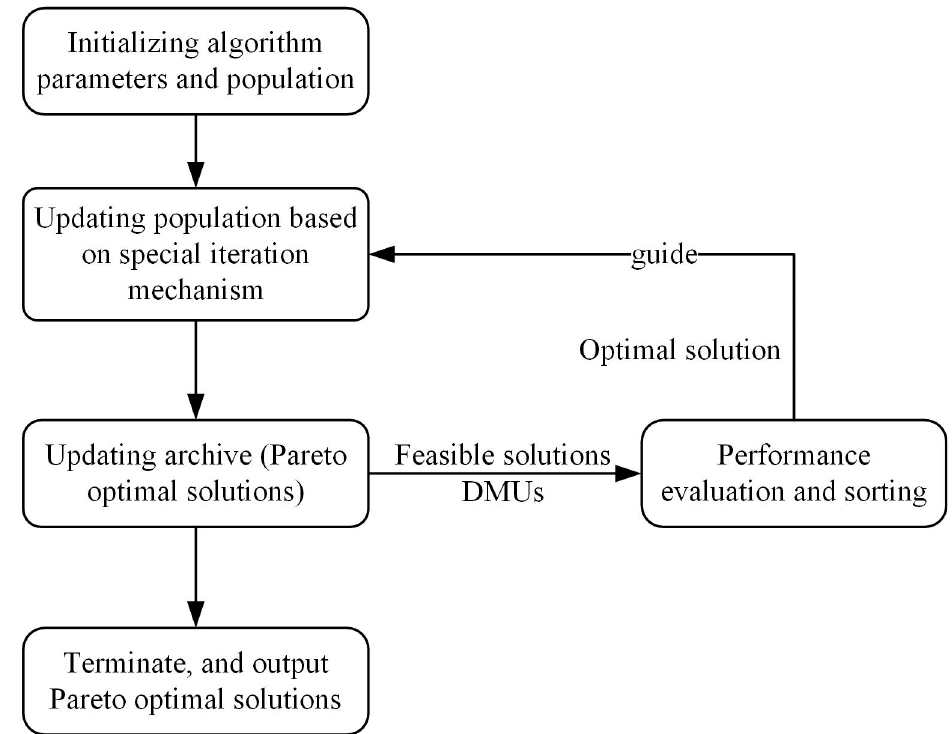
Figure 3. The flow chart of performance-oriented optimization methodology. Step 1: Initialize algorithm parameters and generate the initial